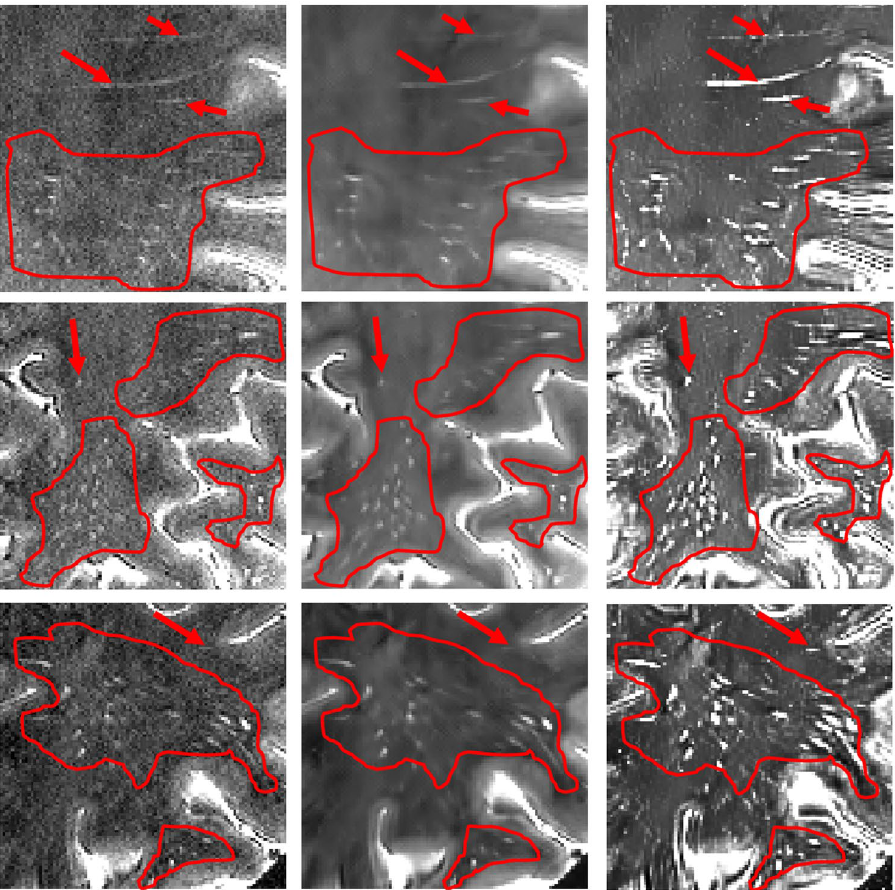
Figure 5. Zoom-in views of the original image (left), the denoised image obtained directly from the original image (middle), and the denoised image from our enhanced image by our complete method (right). Please compare PVSs within contours or pointed by